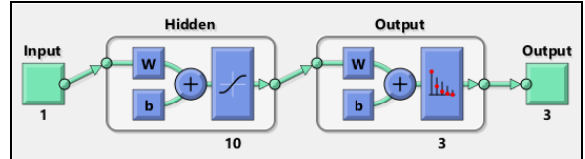
Fig . 7 Artificial Neural Network ( ANN